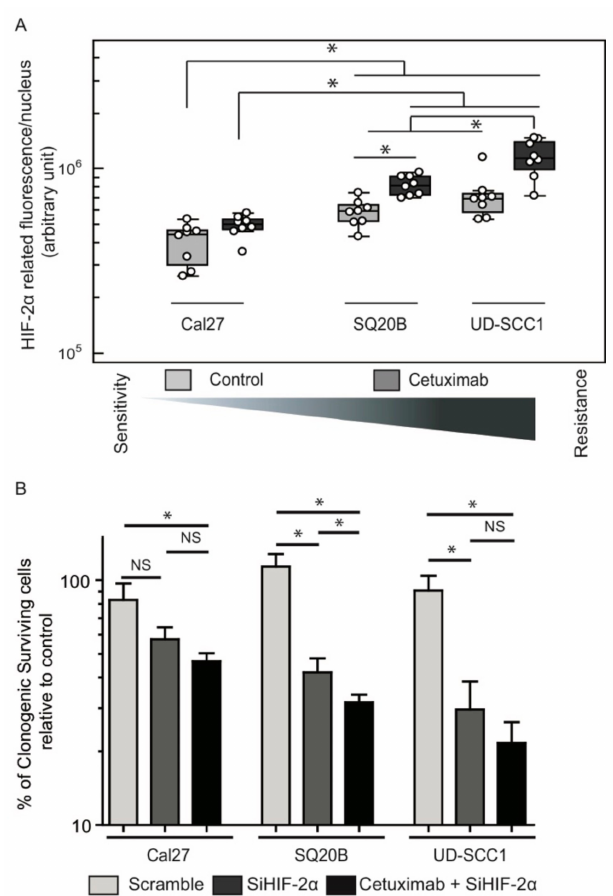
Figure 4. Cetuximab-induced HIF-2 α expression results in oncogenic addiction. ( A ) Relative HIF-2 α protein expression evaluated by fluorescent immunohistochemistry on Cal27, SQ20B and UD-SCC1 cells. Quantification of the signal in each experimental condition was performed on 8 to 10 independent fields from 2 independent experiments (i.e., 4 to 5 fields per experiment). Results are plotted as a box-and-whisker plot representing the median value, the 25th and 75th quartiles. Data in di ff erent populations was compared using a Kruskal-Wallis test (data distribution is non-normal) and two-side Mann–Whitney post-test; * p < 0.05. ( B ) Clonogenic survival assay of Cal27, SQ20B and UD-SCC1 cells treated with cetuximab and / or transfected with anti-HIF-2 α siRNA from 3 independent experiments. Error bars represent the standard deviation (Kruskal–Wallis test and two-side Mann–Whitney test; * p <